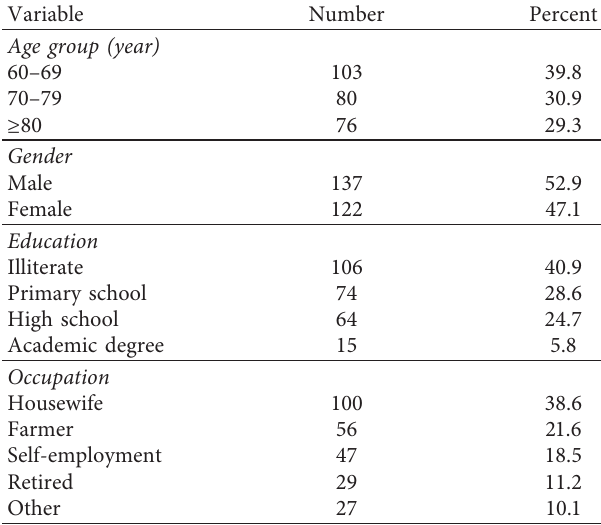
Table 1: Patient demographic